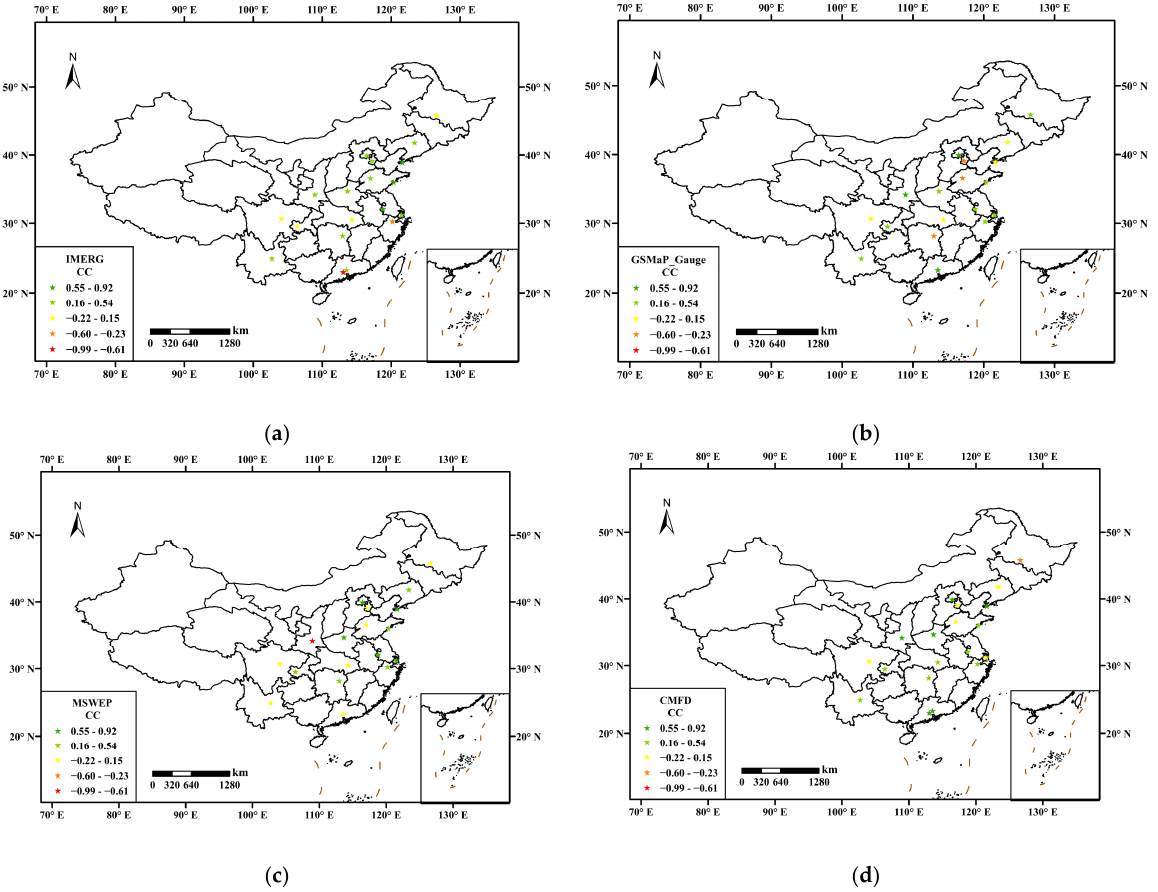
Figure 6. The correlation coefficient between R99 values of SPPs data and rain gauges in 21 major cities:( a ) IMERG, ( b ) GSMaP_Gauge, ( c ) MSWEP, and ( d )